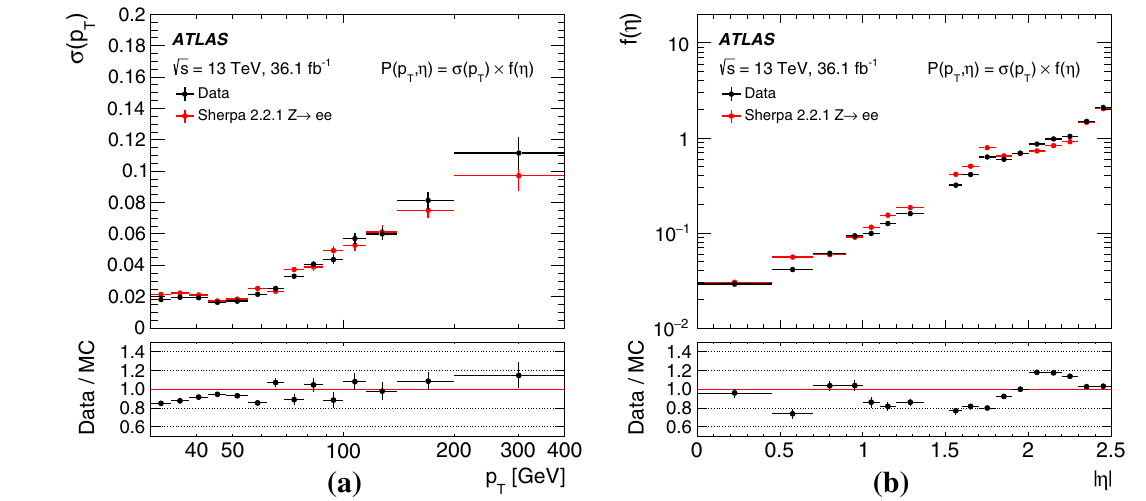
Fig. 3 Comparison of the factors composing the charge misidentifi- cation probability P ( p T ,η) = σ( p T ) × f (η) measured in data and in simulation using the likelihood fit in the Z /γ ∗ → ee region. The area of the distribution describing f (η) was set to unity (see text for details).